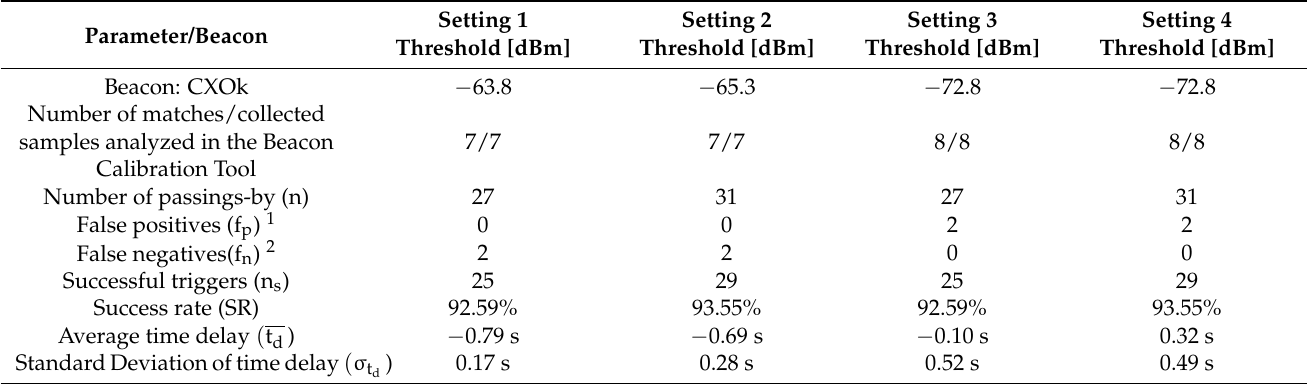
Table 8. Results of Beacon Calibration Tool verification using LM Technologies